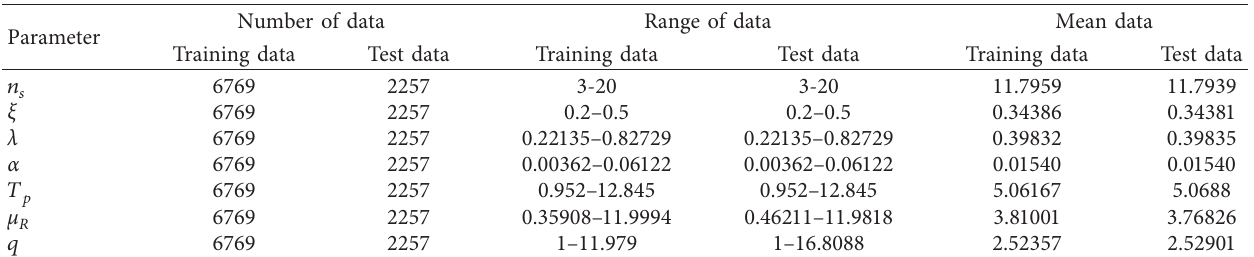
Figure 5: Model validation comparison with the result of Fakhroddini et al. [37]. Table 3: Range of the data